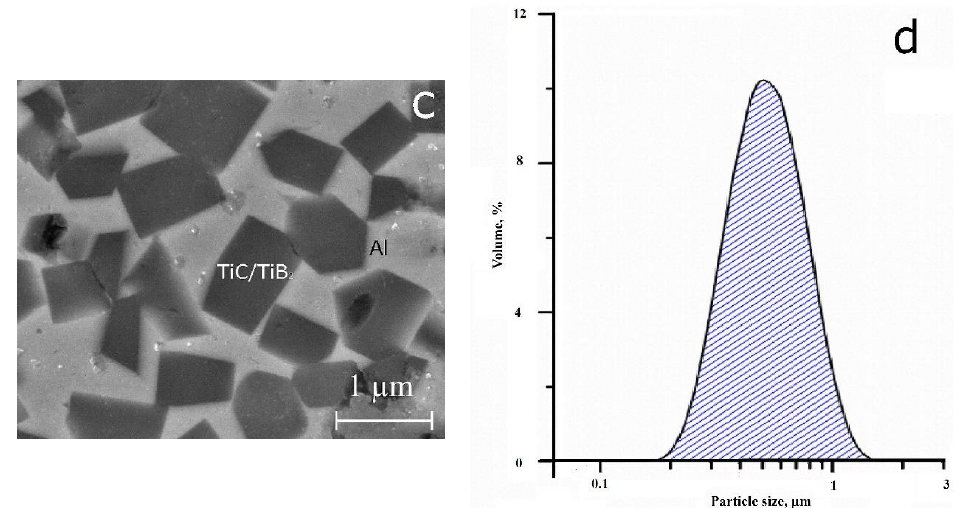
Figure 1. ( a ) The microstructure of the master-alloy 2 SHS composite containing TiB 2 particles. ( b ) Histogram of the ceramic particle distribution (TiB 2 ) by size. ( c ) Master-alloy 1 SHS composite containing TiB 2 /TiC particles. ( d ) Histogram of the ceramic particle distribution (TiB 2 /TiC) by size.